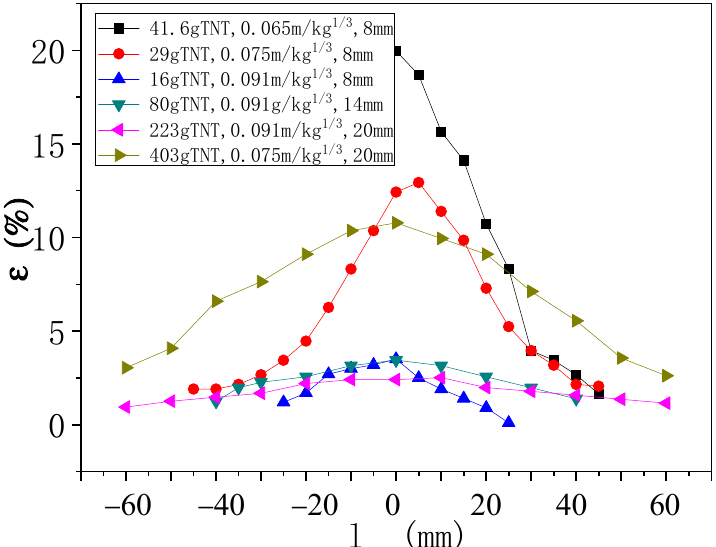
Figure 3. Deformation in different scaled distances and shell thicknesses.